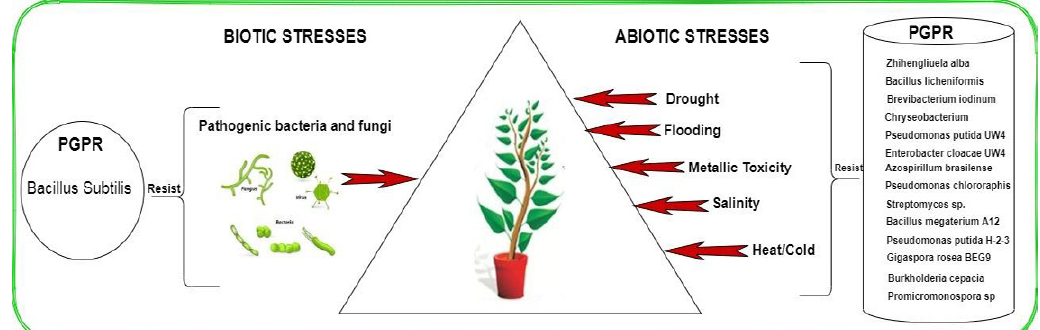
Fig. 1: PGPR in resisting biotic and abiotic stresses